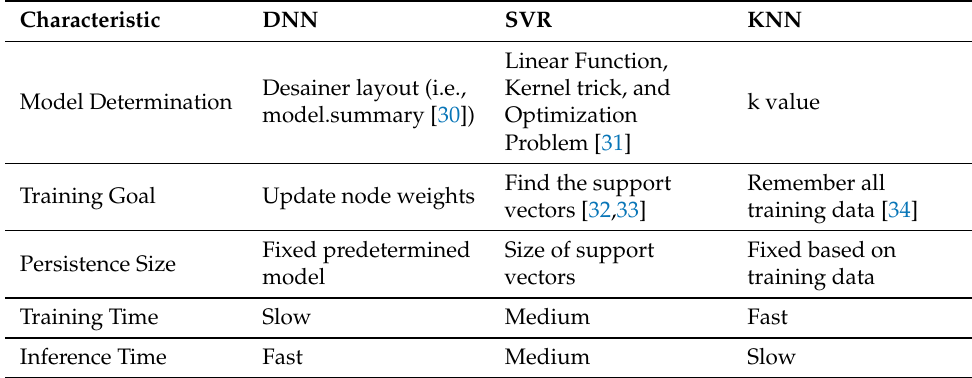
Table 1. General Comparison of Deep Neural Networks (DNN), Support Vector Regression (SVR), and k-Nearest Neighbors (KNN)